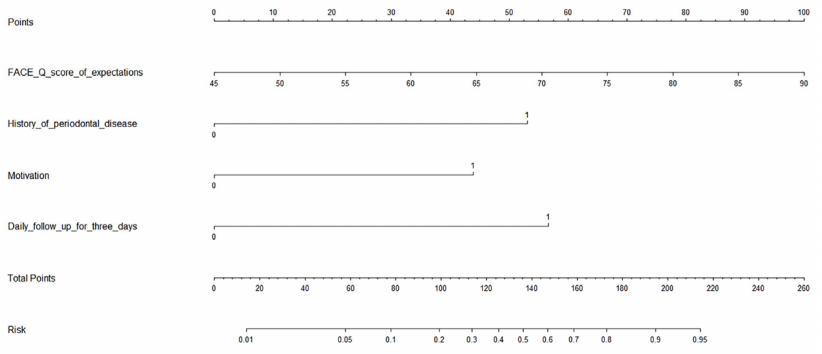
Figure 4. Nomogram (with the regression modeling strategies program) for predicting patient satisfaction after midface augmentation using Bio-Oss bone